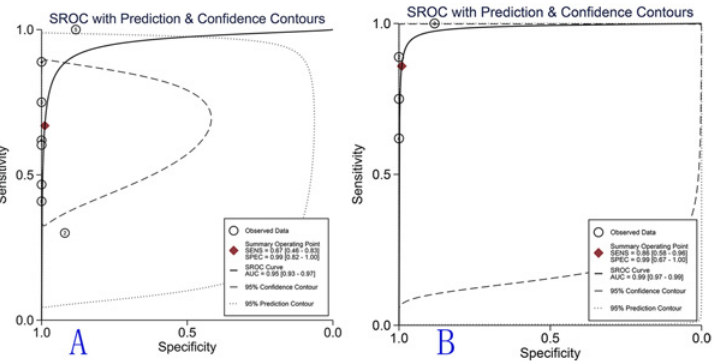
Fig 5. SROC curve for ALK in the diagnosis of IMTs. A. The overall SROC curve for ALK in IMT diagnosis in the 8 included studies. B. The SROC curve for ALK in bladder IMT diagnosis. The solid circles represent each study included in the meta-analysis. The size of each study is indicated by the size of the solid circle.